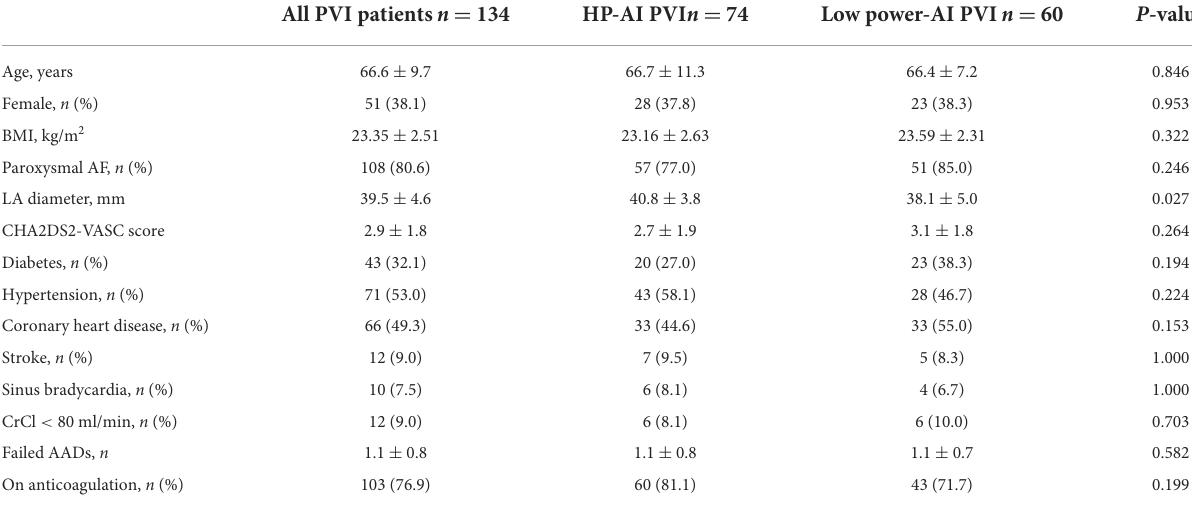
TABLE 1 Characteristics of the HP-AI group and the low power-AI group.